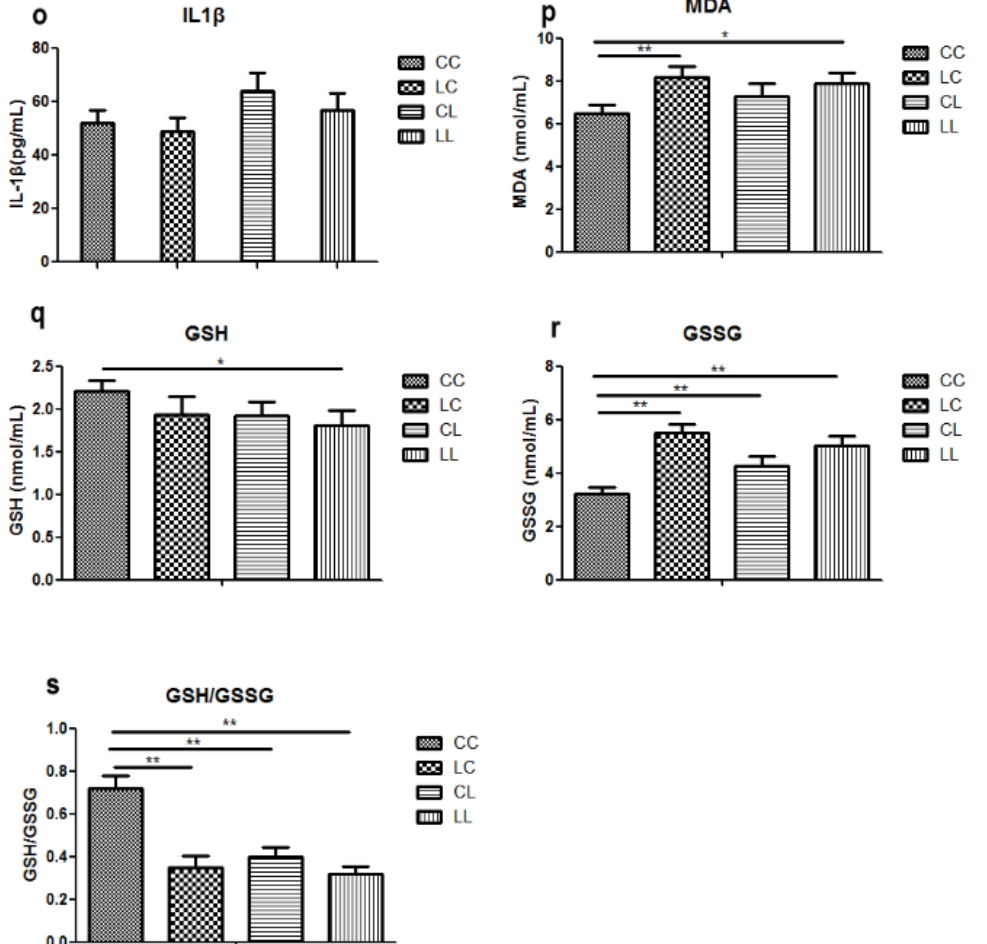
Figure 2. Effects of maternal low chromium diet on serum chromium ( a ); body weight ( d ); food intake ( e ); fat pad weight ( f ); serum total cholesterol ( g ); triglyceride ( h ); HDL ( i ) and LDL ( j ); leptin ( k ); adiponectin ( l ); TNF- α (m); IL-6 ( n ); IL-1 β ( o ); MDA ( p ); GSH ( q ); GSSG ( r ); GSH/GSSG ( s ) at 32 weeks of age; birth weight ( b ) and weaning weight ( c ). Values are mean ± SD, n = 8 per group. * p < 0.05, ** p < 0.01.